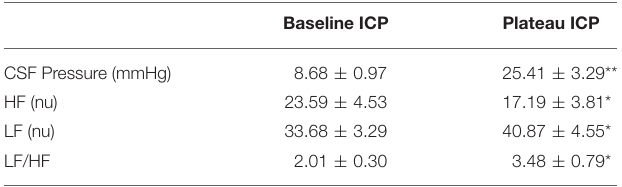
TABLE 4 | Results of heart rate variability analysis during modest ICP increase in human ( n = 10).